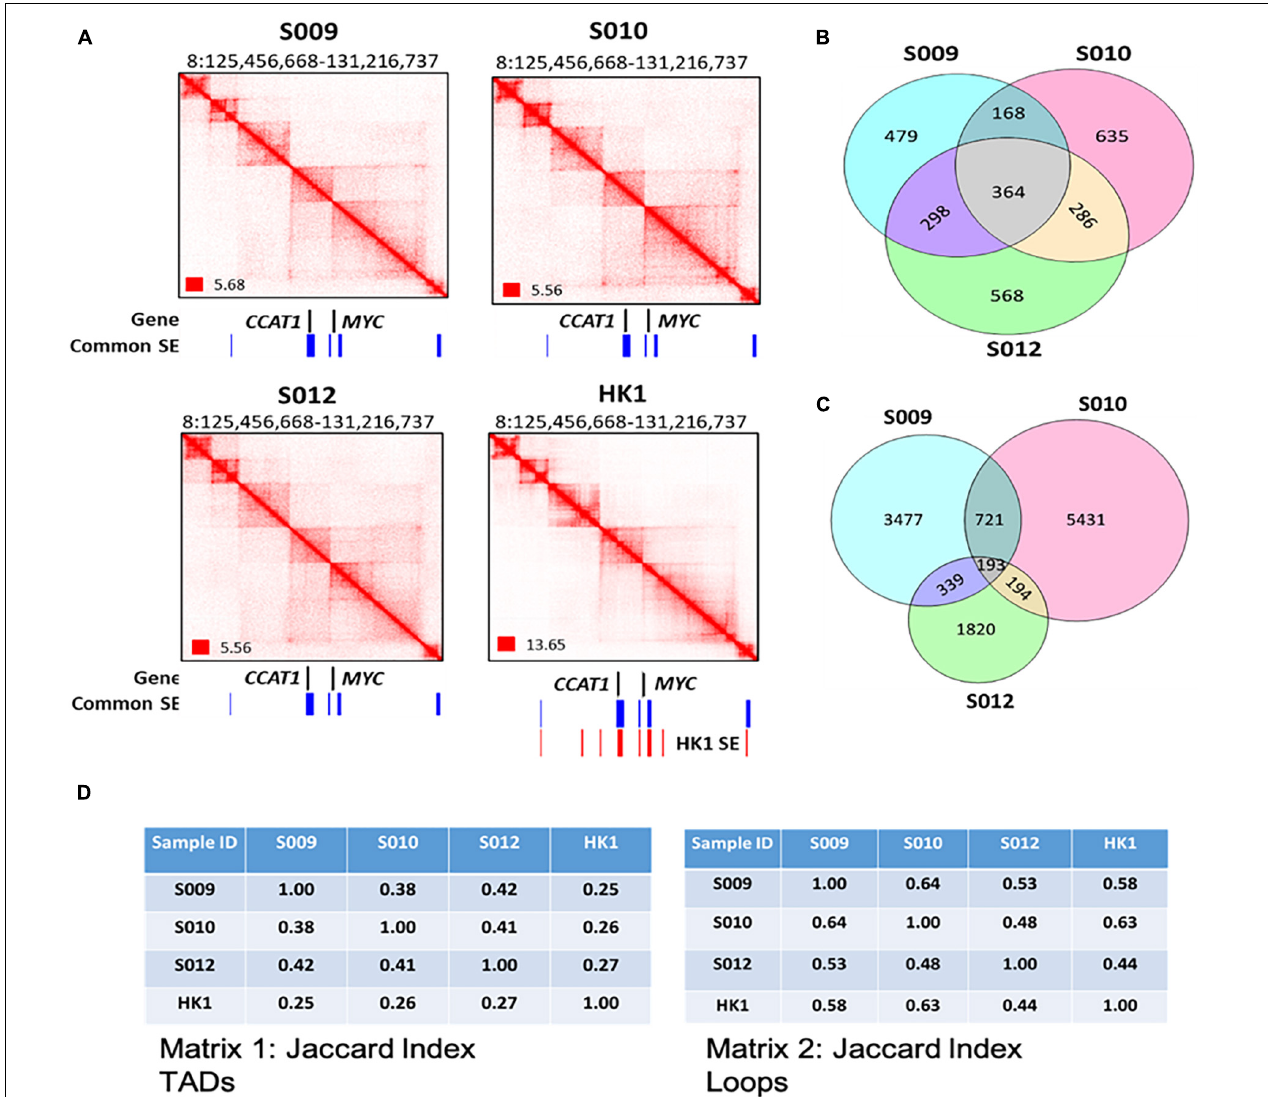
FIGURE 2 | A genome-wide map of 3D genome organization in nasopharyngeal cancer. (A) Biop-C heatmaps can detect various conformational genomic features such as TADs, loops, and FIREs in S009, S010, and S012 at CCAT1 and MYC . Coverage normalization was used to visualize the Biop-C and Hi-C heatmaps in Juicebox (Durand et al., 2016). Genes are indicated in black color. The “common super enhancers,” shown in blue color, indicate the super enhancers present in all three NPC cell lines—HK1, C66-1, and HNE1 cell lines. The super enhancers present in HK1 cell lines are indicated in red color. The super enhancer datasets are obtained from Ke et al. (2017). (B) Venn diagram showing the overlap of TAD boundaries between the patients inferred using the Arrowhead algorithm (Rao et al., 2014) at 10 kb resolution. (C) Venn diagram depicting the overlap of loops between the patients. The loops were called using the HiCCUPS algorithm (Rao et al., 2014) at 5, 10, and 25 kb resolution. The loops of the different resolutions were merged for this analysis. (D) Jaccard index. Matrix 1: Jaccard indices for TADs in NPC samples S009, S010, and S012 and cell line HK1; each cell in the matrix indicates the Jaccard index value for the column sample and row sample. Matrix 2: Jaccard indices for loops in NPC samples S009, S010, and S012 and cell line HK1 where each cell of the matrix indicates the Jaccard index value for the column and row